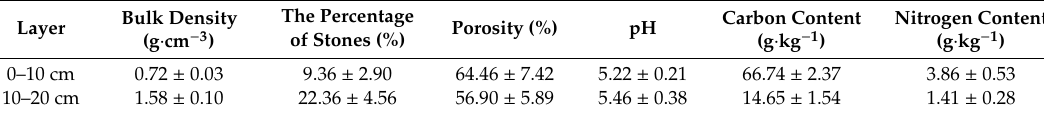
Table 1. Soil characteristics of the Larix gmelinii forest